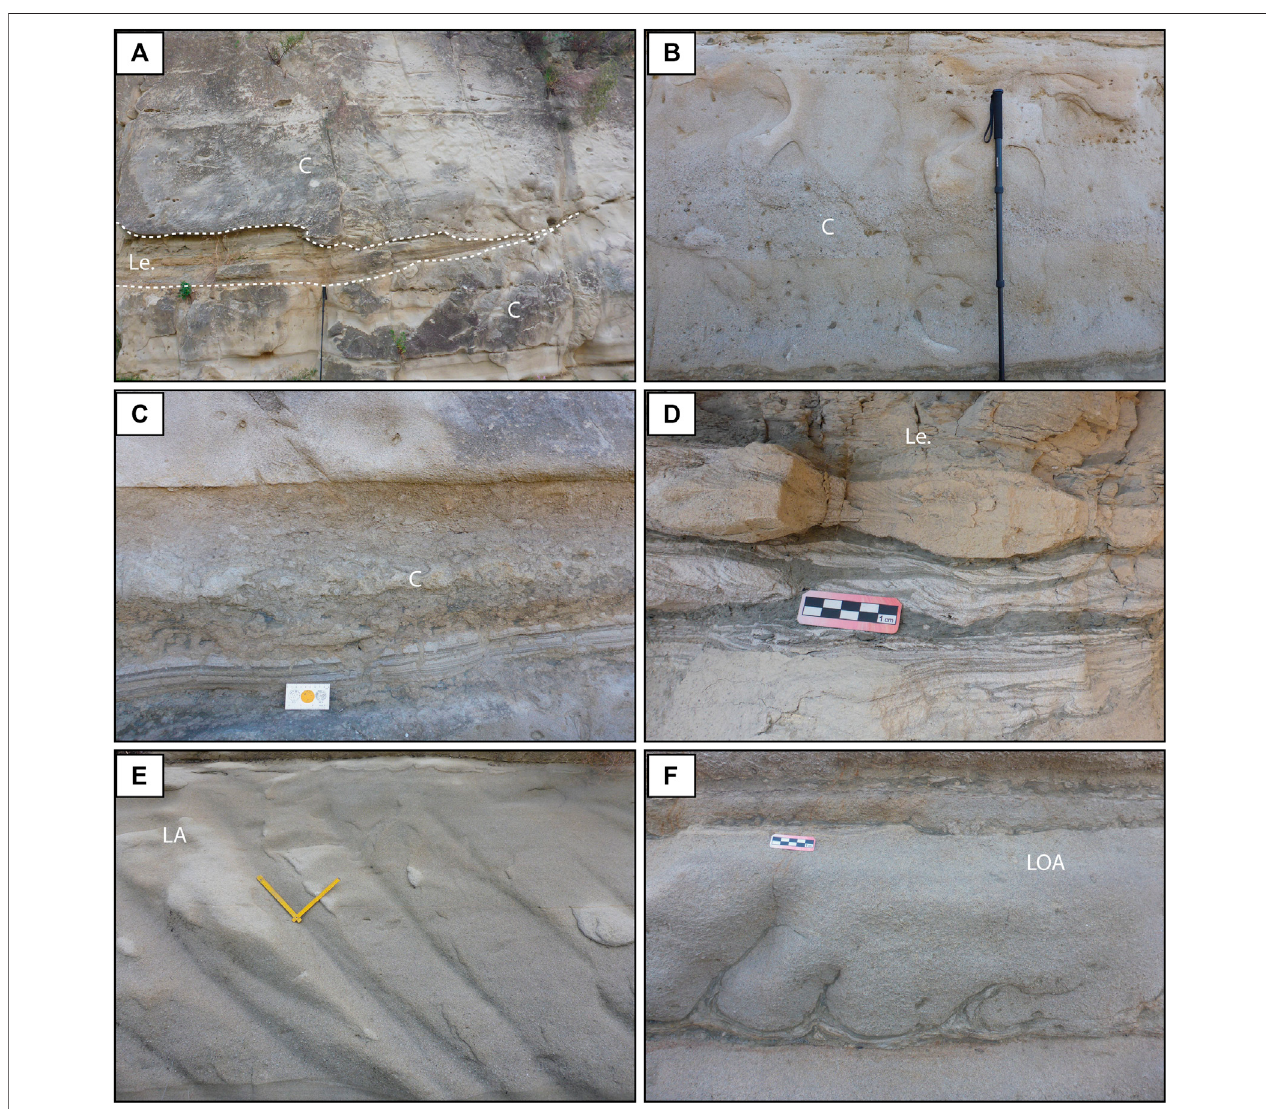
cross-strati fi cation. 1.5 m-long Jacob staff for scale. (C) Highly bioturbated siltstones to very fi ne-grained sandstones commonly preserved at the top of the Channel- Levee (C-Le) facies association. (D) Siltstones to very fi ne-grained sandstones with climbing- and current-ripple structures illustrating the Levee (Le) facies association. (E) Lobe axis (LA) facies association represented by weak normal grading, m-thick beds of gravelly to very coarse- and medium-grained sandstones showing parallel lamination. Folding rule meter for scale, 20-cm long segments. (F) Lobe off-axis (LOA) facies association illustrated by normally graded coarse- to fi ne- grained sandstone beds with erosive base and fl ame structures, alternating with fi ner-grained deposits with current ripples.